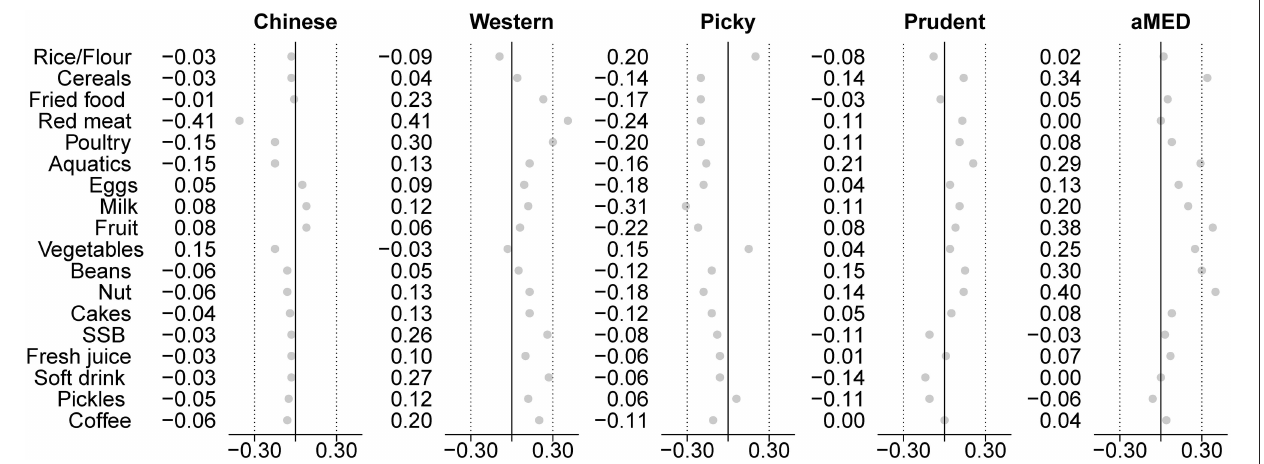
FIGURE 3 | Correlations between food consumption and the dietary pattern, based on the posterior LCA method and the prior diet quality index (DQI) method. Compared with the data-driven “posterior” method, the “ a priori ” method has a clearer biological meaning under a certain diet pattern. This study found that in terms of its relevance to the specific food group, the Prudent -dietary pattern from LCA is similar to the Mediterranean dietary pattern.